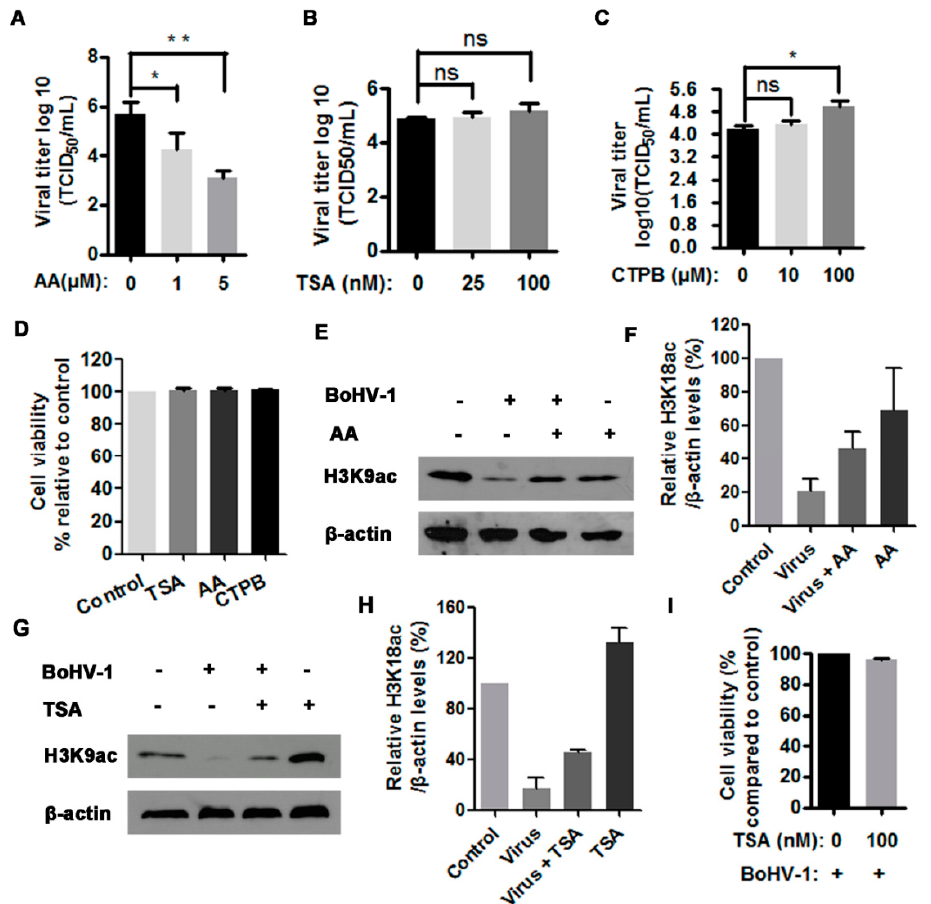
Figure 3. The effects of HAT inhibitor on BoHV-1 productive infection. ( A – C ) MDBK cells in 24-wells plates were infected with BoHV-1 (MOI = 1) and treated with anacardic acid (AA) (0, 1 and 5 µM) ( A ), TSA (trichostatin A) (0, 50 and 100 µM) ( B ), CTPB [ N -(4-Chloro-3-trifluoromethylphenyl)-2-ethoxy-6-pentadecylbenzamide] (0, 10 and 100 µM) ( C ) or DMSO control for 1 h, respectively. After three washing with PBS, fresh medium with either inhibitors or DMSO control were replaced. At 24 hpi, viral yields were determined in MDBK cells. Data represent three independent experiments. Significance was assessed with the student t test (* p < 0.05, ** p < 0.01, ns: not significant). ( D ) The cytotoxicity of AA (5 µM), TSA (100 µM), and CTPB (100 µM) was analyzed in MDBK cells with Trypan-blue exclusion test. Data represent means of three independent experiments. ( E , G ) MDBK cells in 60 mm dishes were uninfected or infected by BoHV-1 at an MOI of 1, along with the treatment of either AA (5 µM) ( E ) or TSA (100 nM) ( G ), or DMSO control. At 16 hpi, cell lysates were prepared and subjected to Western blots to detect the expression of H3K9ac. Data represent three independent experiments (+: indicated compound or virus was present, − : indicated compound or virus was not present). ( I ) The virus infected MDBK cells were mock treated with DMSO or TSA (100 nM) throughout infection. At 24 hpi, the cell viability was detected with Trypan-blue exclusion test. Data represent means of three independent experiments. ( F , H ) The band intensity was analyzed with software image J. Each analysis was compared with that of uninfected control which was arbitrarily set as 100%. The error bars denote the variability between the three independent experiments.